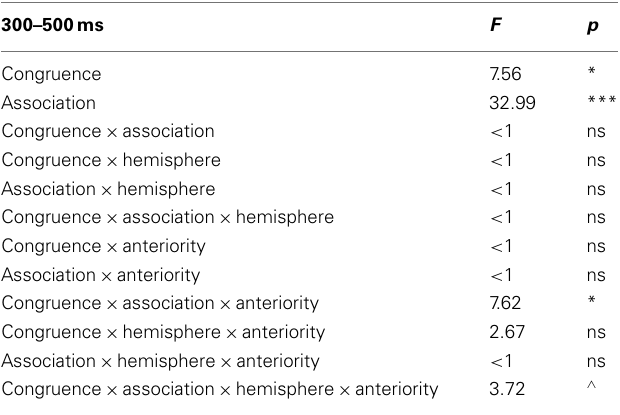
Table 2 | Results of discourse congruence and lexical association from repeated measuresANOVA, including topographic factors of Anteriority and